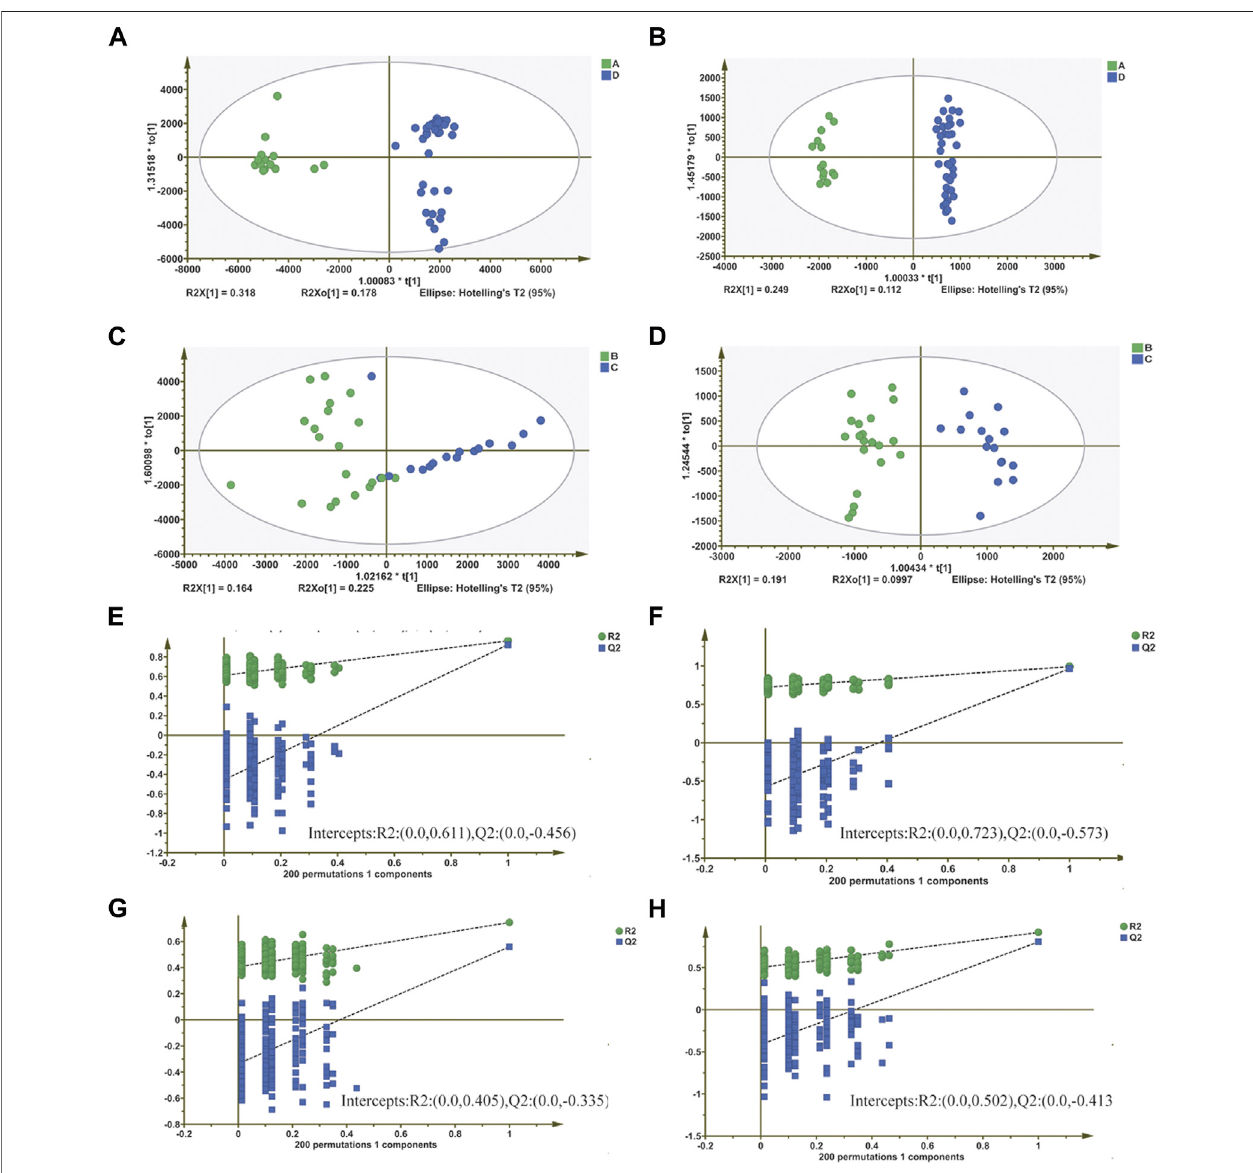
FIGURE 2 | Screening of differential metabolites based on orthogonal partial least squares discriminant analysis (OPLS-DA) model. (A,B) OPLS-DA score plots based on serum metabolic pro fi les of ALL and AML groups in positive and negative modes. (C,D) OPLS-DA score plots based on serum metabolic pro fi les of within the AML group in positive and negative modes. (E – H) Permutation test of OPLS-DA model for different comparison groups.